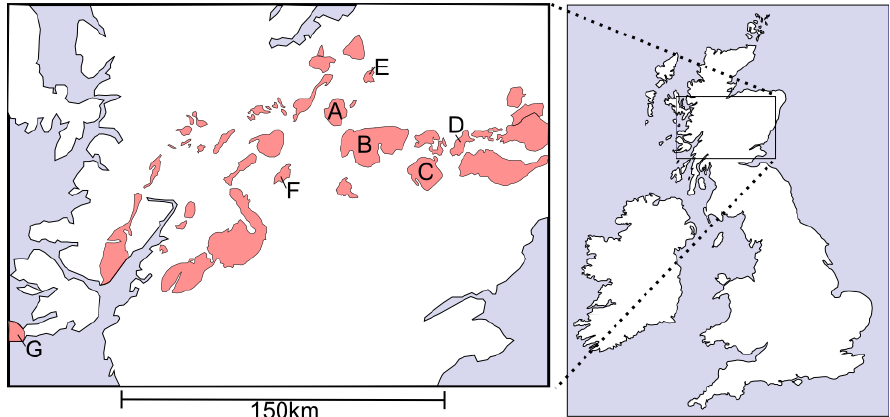
Figure 9. Locations of the studied granite plutons: Monadhlaith (A), Cairngorm (B),